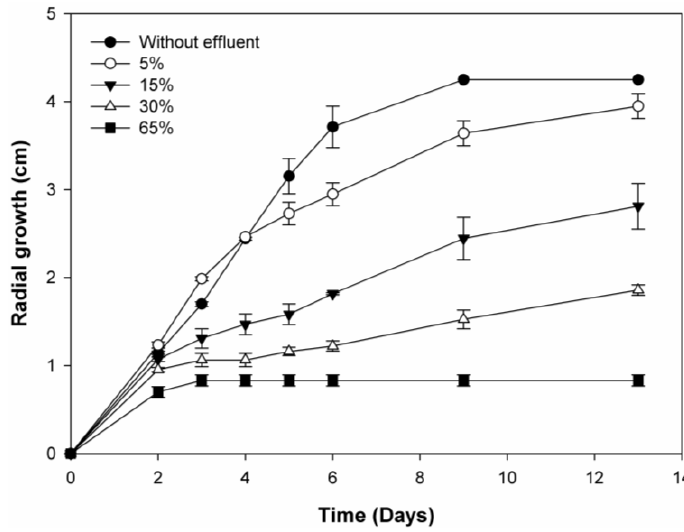
FIGURE 2. Radial growth of the Tv CDBB-H-1051 in Petri dishes with several concentrations of a textile effluent with cochineal extract. Bars represent standard